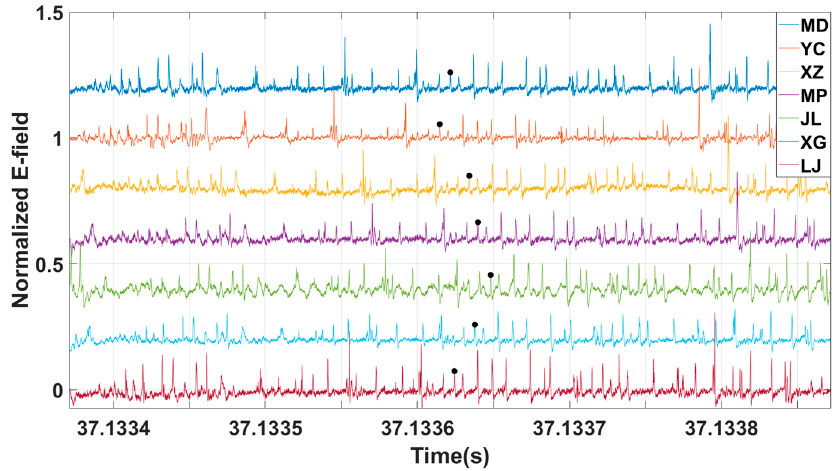
Figure 6. A set of matched pulses.